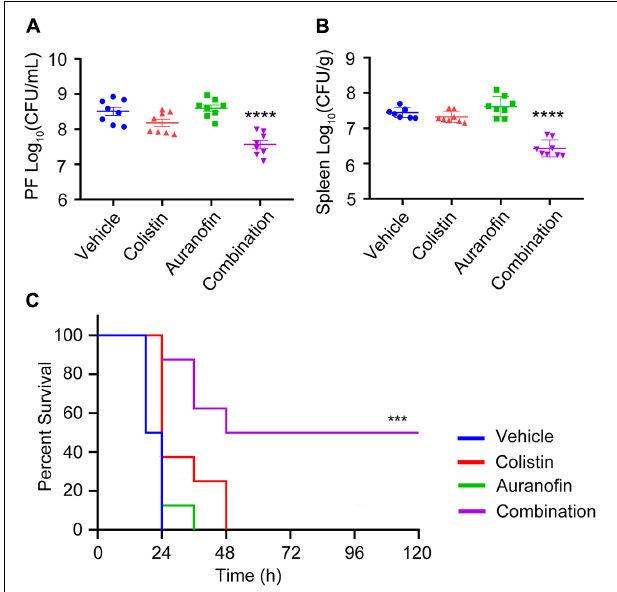
FIGURE 4 | The combination of colistin and auranofin shows potency in vivo . (A,B) Mice were infected by high-level Col-R K. pneumoniae 18605 and received single dose of i.p. administration of vehicle, colistin sulfate, auranofin, or their combination ( n = 8 per group). Bacterial loads in the PF (A) and spleen (B) are shown. (C) Survival curves showing combination efficacies in the peritoneal infection model. Mice were infected by a lethal dose of high-level Col-R A. baumannii 13660 and treated with one dose at 0.5 h post infection, followed by once-daily treatment with i.p. vehicle, colistin sulfate, auranofin, or the combination ( n = 8 per group). ****indicates p ≤ 0.0001, ***indicates p ≤ 0.001, compared with the control